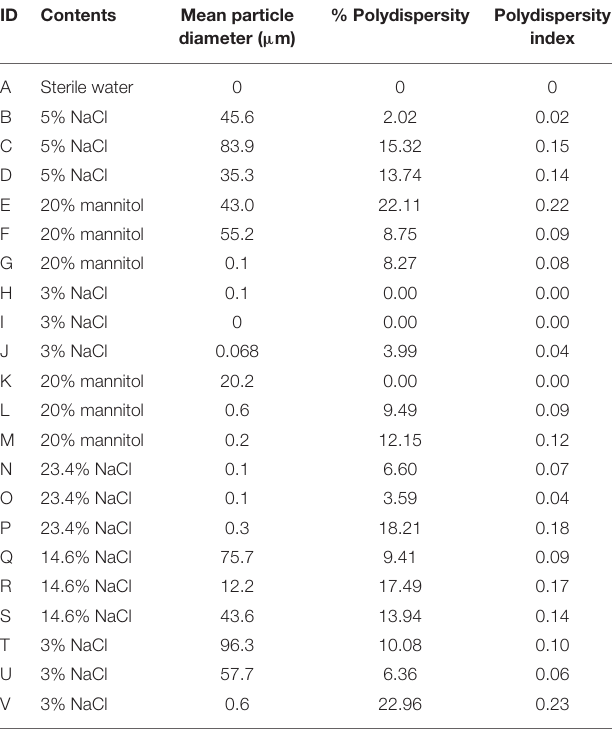
TABLE 2 | Dynamic light scattering nephelometry data for solutions A through